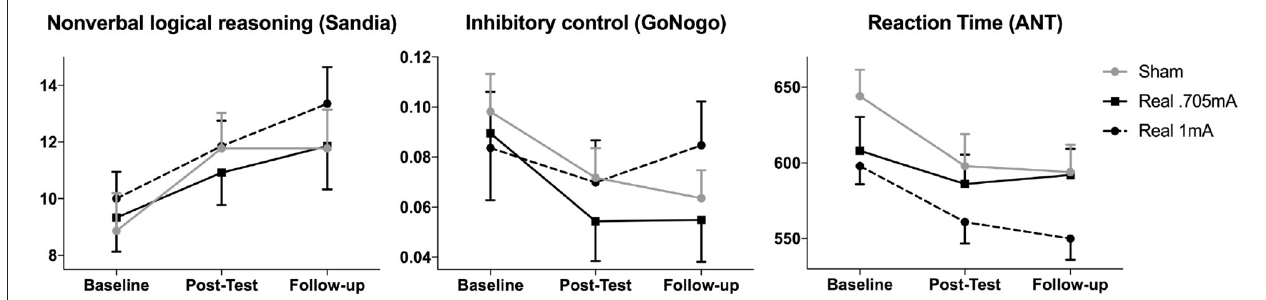
FIGURE 2 | Cognitive performance over time. The main outcome measure non-verbal logical reasoning (Sandia) as well as inhibitory control (GoNogo false alarms) and reaction time (ANT) improved significantly over time across groups, but stimulation did not differentially affect this improvement. These improvements were driven by significant changes during the intervention (from baseline to post-test) in all three measures (mean and standard errors are shown).